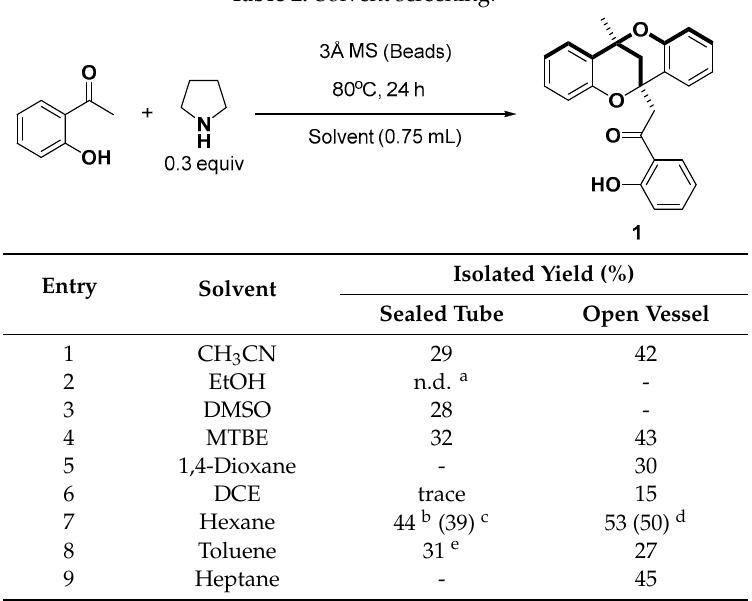
Table 2. Solvent Table 2. Solvent screening.